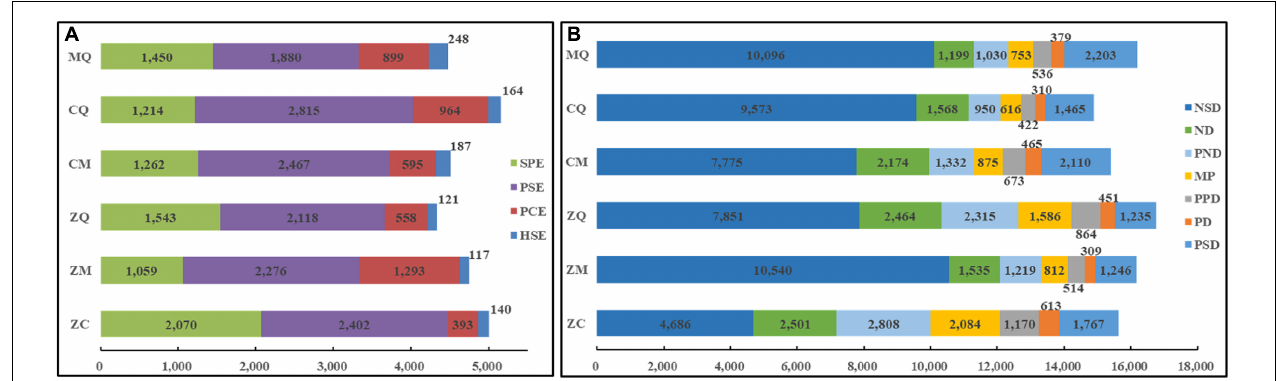
FIGURE 3 | Gene expression patterns in seeds of hybrids. The differential expression of DEGs in seeds of hybrids with PAV (A) and PHCE patterns (B) , where the expression quantity of different types of genes is marked on the bar, and different colors in the figure represent different types of DEGs listed on the right side of the figure. The abscissa is the number of differentially expressed